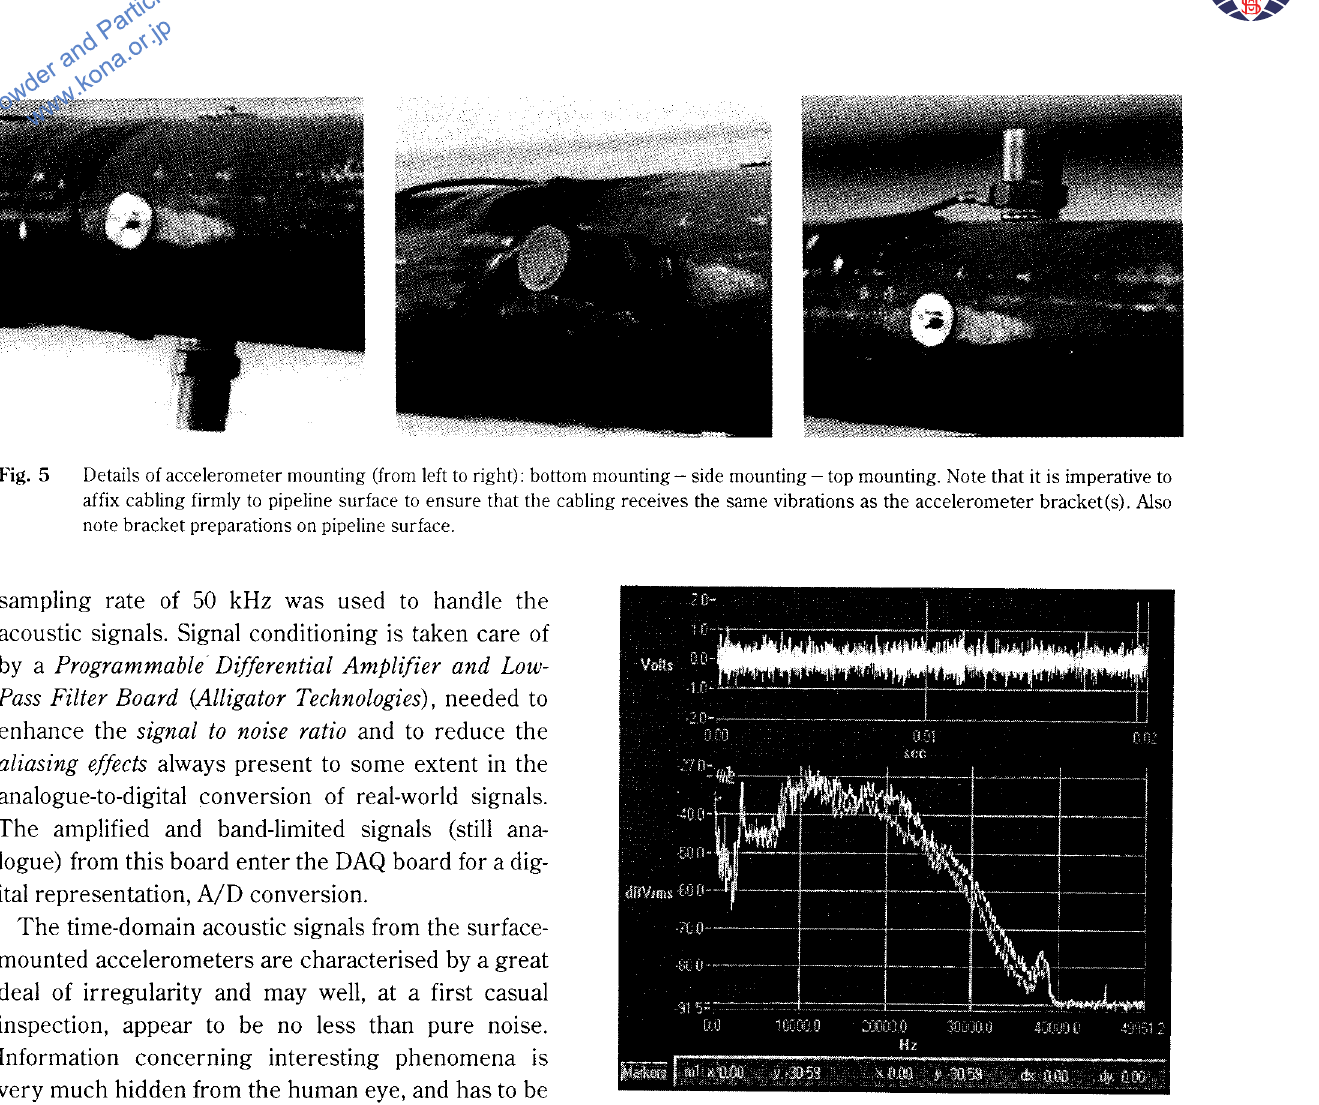
Time-domain (top panel) to frequency-domain representa tion